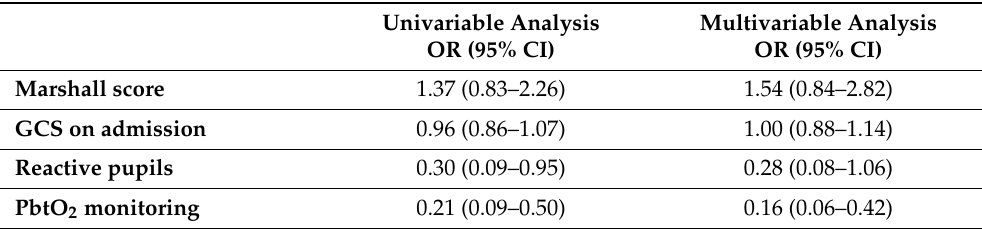
Table 3. Univariable and multivariable analysis of factors associated with the development of intracranial hypertension during ICU stay. Data is expressed as odds ratio (OR) and 95% confidence intervals